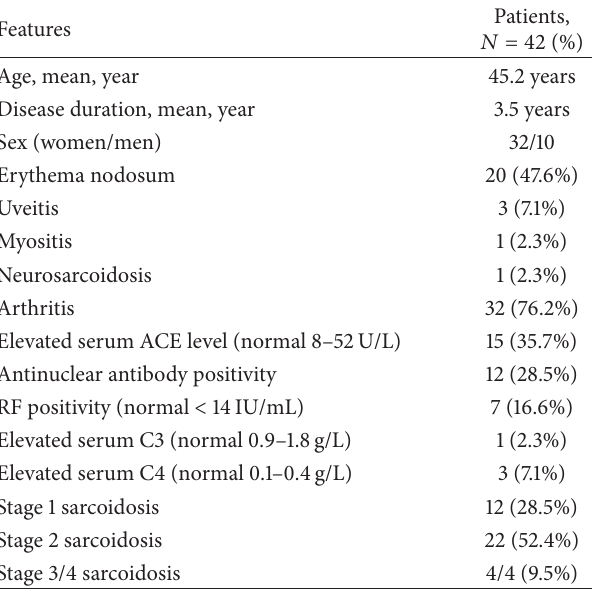
Table 1: Demographic, clinical, and laboratory features in patients with